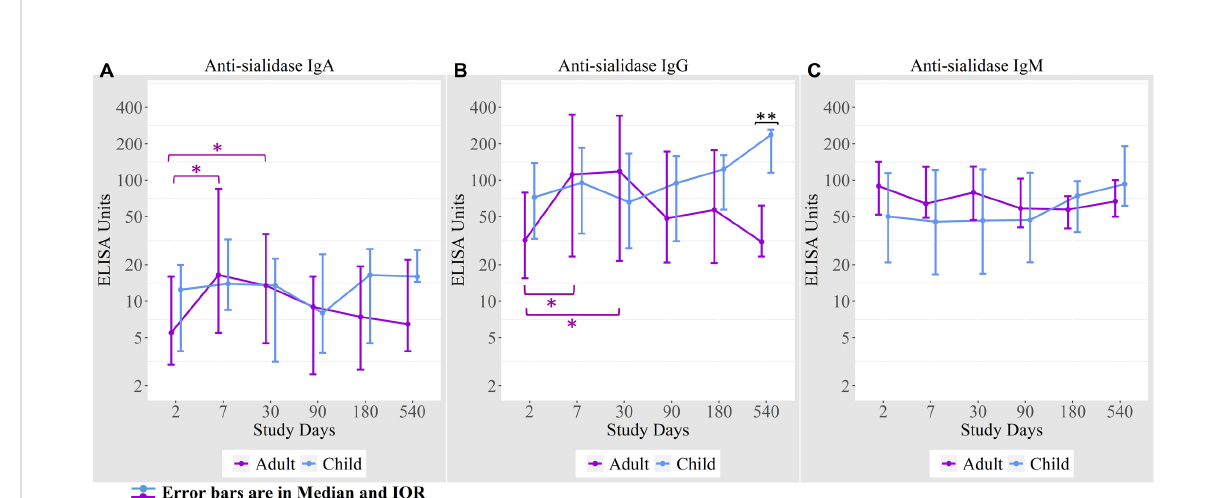
FIGURE 2 Anti-sialidase antibody responses in cholera cases in adults and children over the course of the study. (A) Anti-sialidase IgA responses among adults and children (B) Anti-sialidase IgG responses among adults and children (C) Anti-sialidase IgM responses among adults and children. Kruskal-Wallis test has done in order to identify the signi fi cant difference in median responses of anti-sialidase. *p=0.05- 0.01; **p=0.01-0.001. The purple asterisks denote comparisons in adult patients to day 2, and the black asterisks denote the difference between children and adult cases.